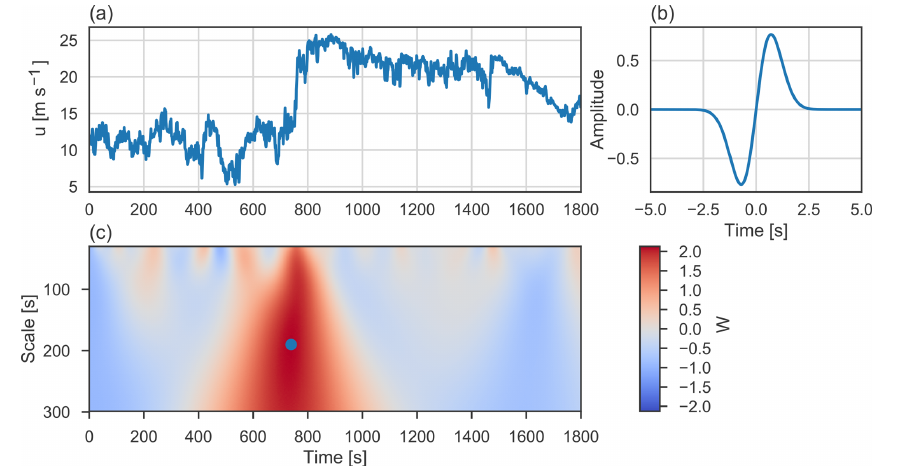
Figure 3. The continuous wavelet transform of a ramp-like coherent structure. (a) : 30min wind speed signal at 100m, Høvsøre. (b) : the flipped DOG1 wavelet used for the wavelet transform. (c) : the wavelet coefficients of the normalized wind speed signal. The maximum coefficient is shown with a blue dot at (cid:96) = 190 s and t (cid:48) = 739s.